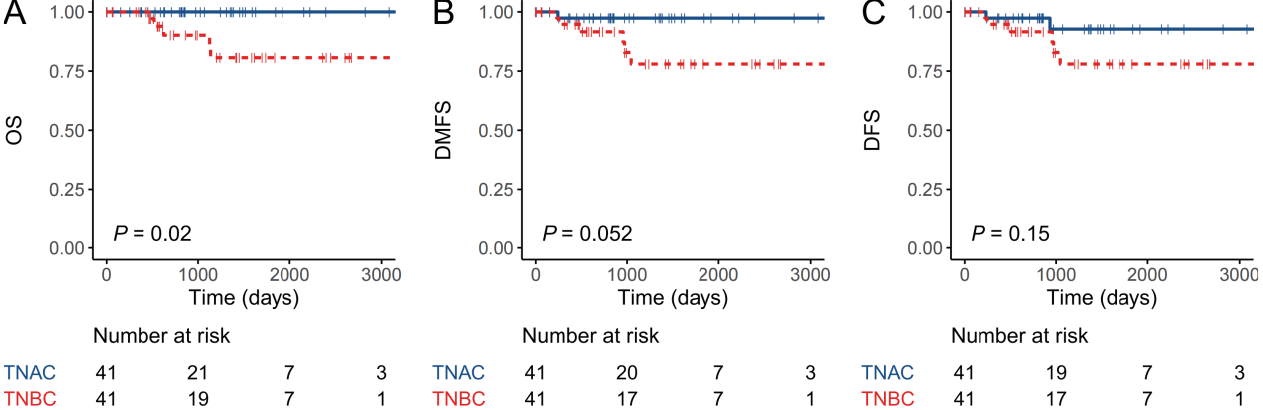
Figure 2. Survival plot for TNAC and TNBC-NA cohort. ( A ) Overall survival (OS), ( B ) distant metastasis-free survival (DMSF) and ( C ) disease-free survival (DFS) of TNAC and TNBC-NA groups were analyzed with Kaplan–Meier curve.